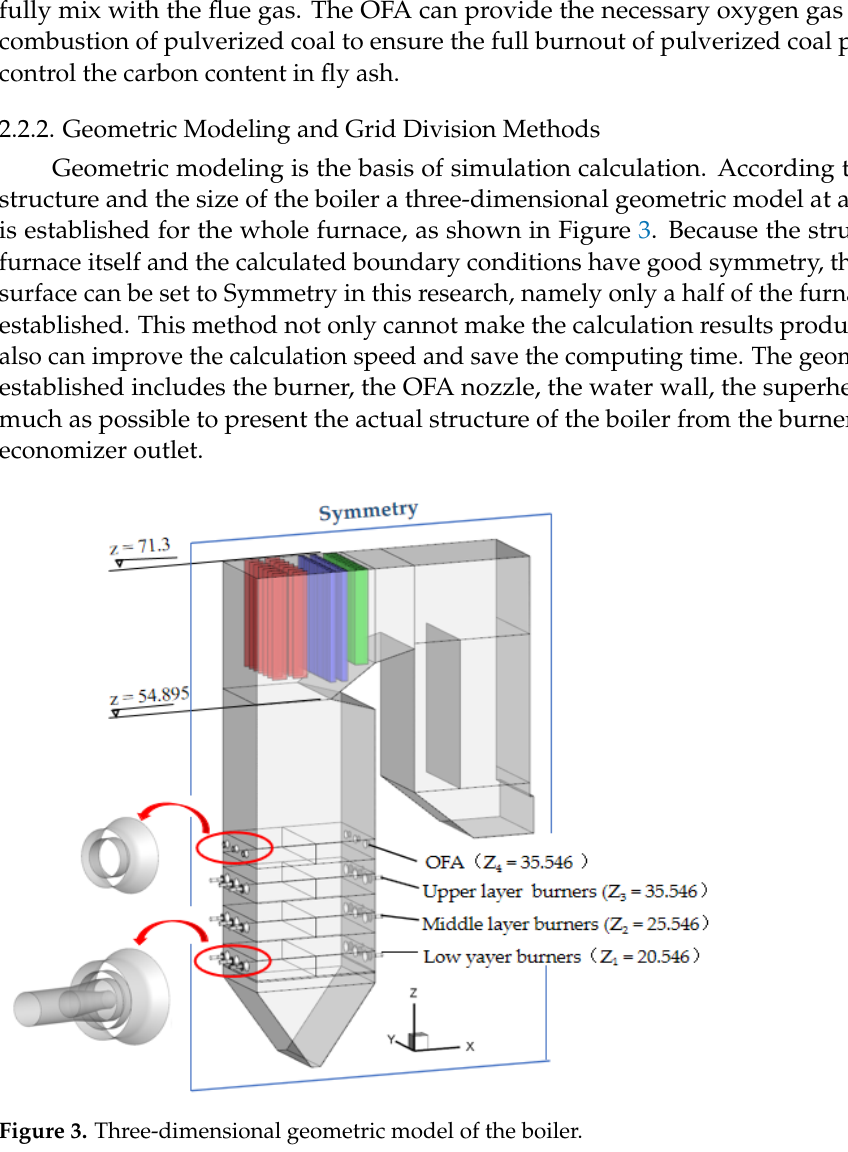
Figure 3. Three-dimensional geometric model of the boiler.